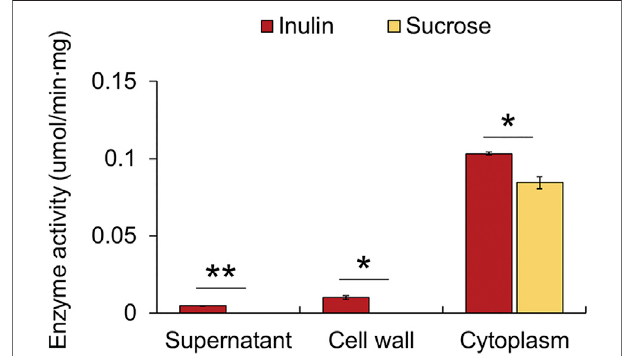
FIGURE 5 | Fructan hydrolase enzyme activities in three fractions of the cell: cell-free supernatant, cell wall extract, and cytoplasmic extract. The activitywasmeasuredbydeterminingtheamountoffructosereleasedpermin per mg of protein. The error bars indicate the standard deviation of duplicate samples. * p < 0.05, ** p < 0.01.